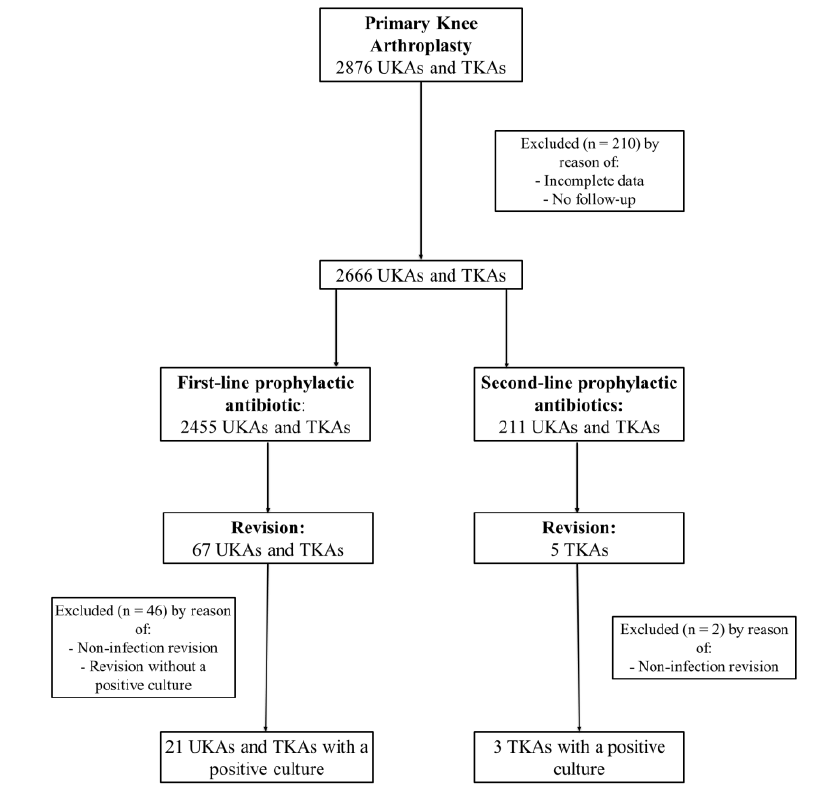
Figure 2. Flowchart of patients’ inclusion criteria in UKA and TKA group.